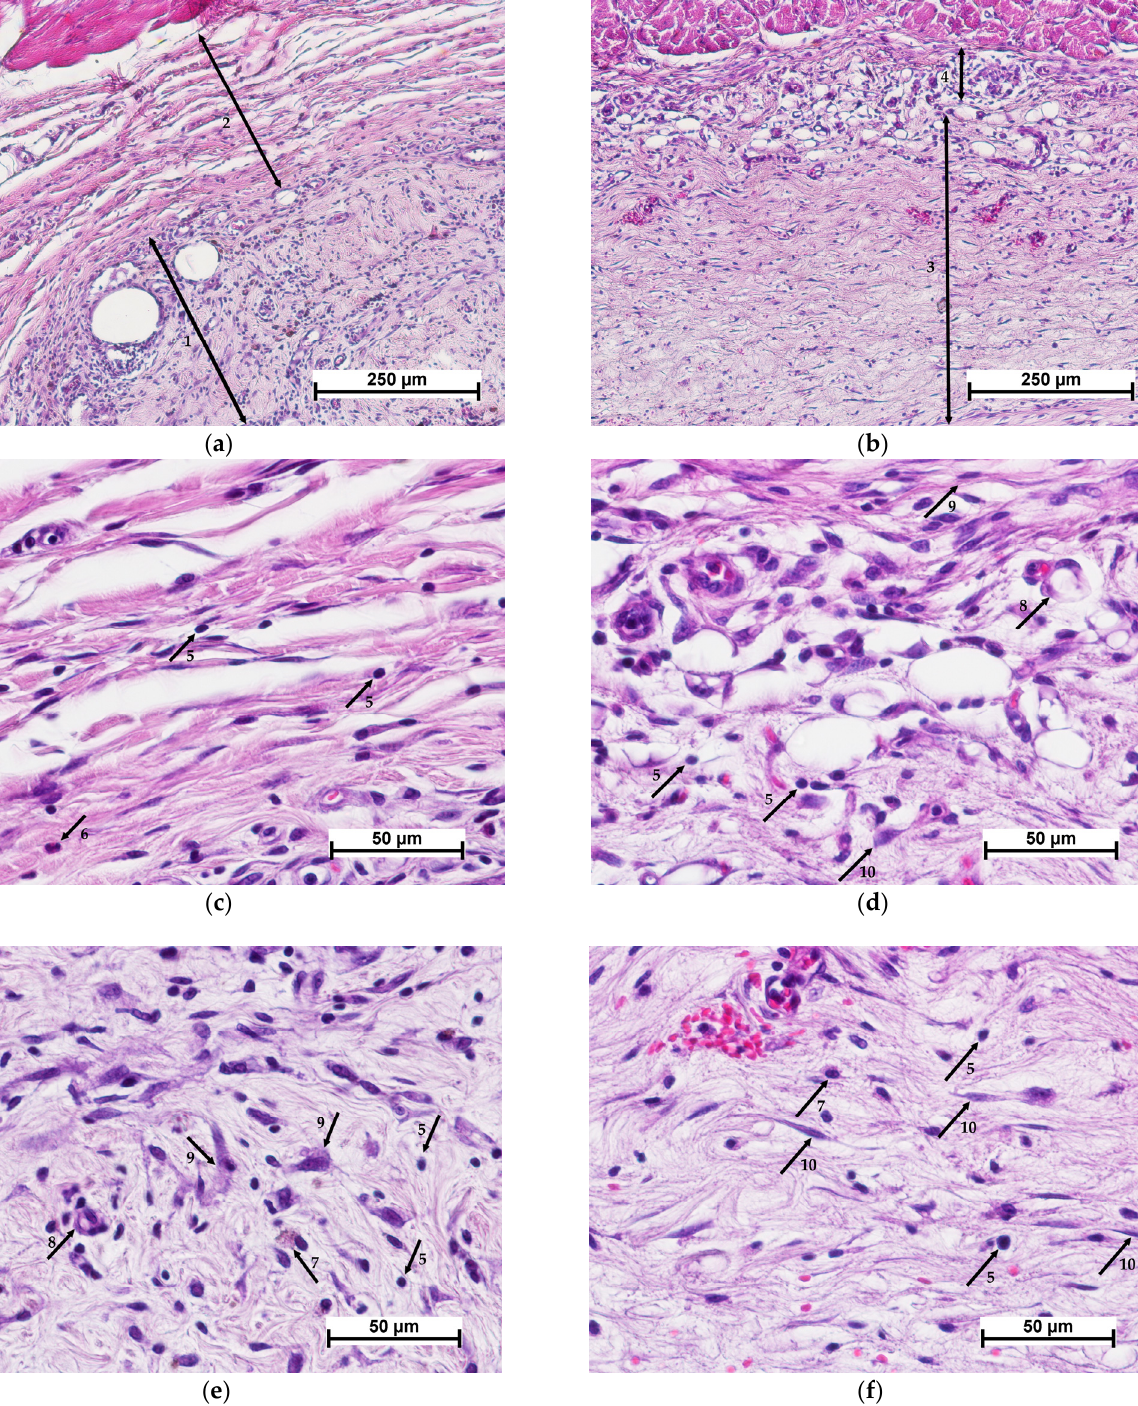
Figure 5. Histological picture—day 14. Comparison of cell-free scaffold ( a , c , e ) and collagen matrix ( b , d , f ). ( a , b )—implant with surrounding tissue, general view, ( c , d )—connective tissue structure surrounding the implant, ( e )—connective tissue at the cell-free scaffold site, ( f )—collagen matrix structure. Staining with hematoxylin–eosin. Note: (1)—connective tissue replacing the scaffold; (2)—connective tissue surrounding the scaffold; (3)—collagen matrix; (4)—connective tissue structure around the implant; (5)—lymphocyte; (6)—granulocyte; (7)—macrophage; (8)—blood vessel; (9)—fibroblast; (10)—fibrocyte.